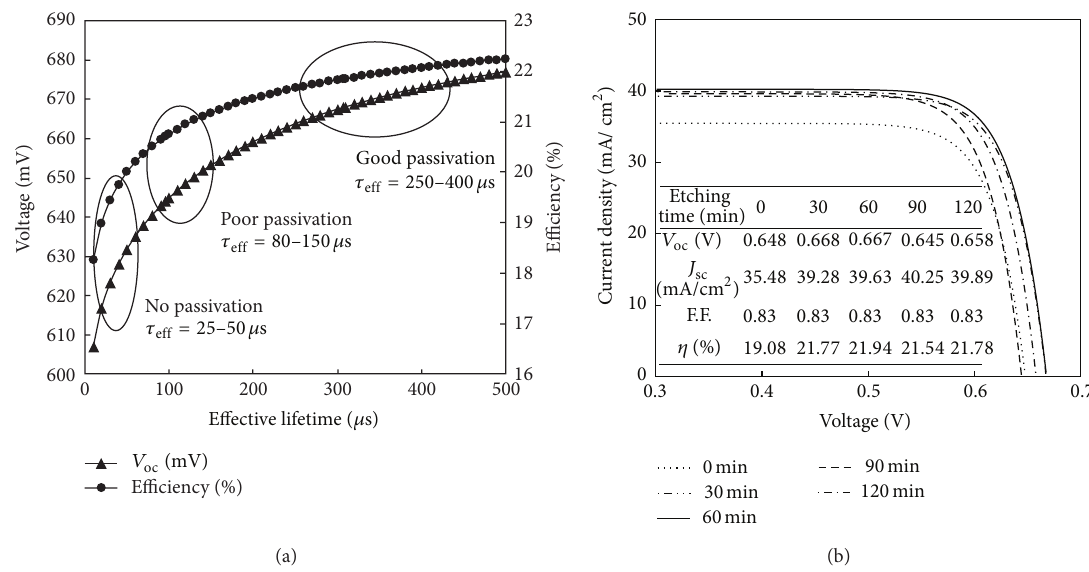
Figure 5: (a) Simulated open-circuit voltage and conversion efficiency as a function of minor carrier lifetimes. (b) Simulated 𝐽 - 𝑉 curves of HJ solar cell with different etching times. Table 1: Simulation parameters for HJ silicon solar